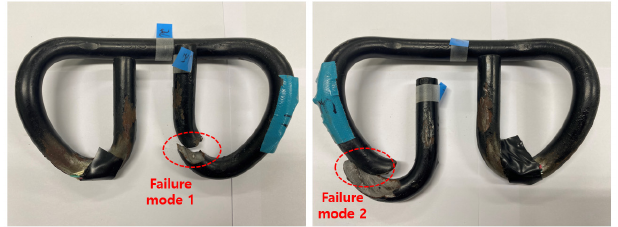
Figure 4. Failure modes of KR-type fastening spring from fatigue testing.